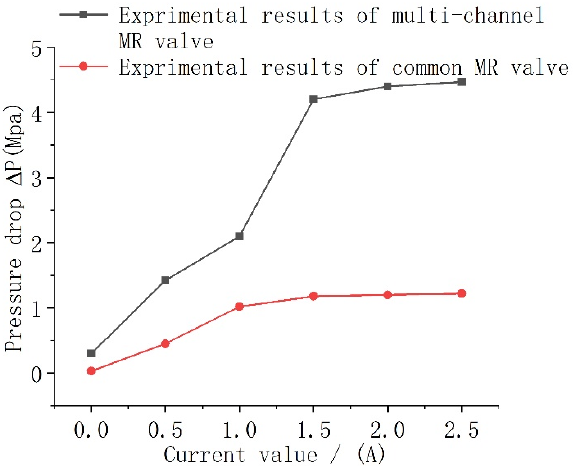
Figure 13. Comparison of pressure drop between annular multi-channel MR valve and ordinary MR valve.